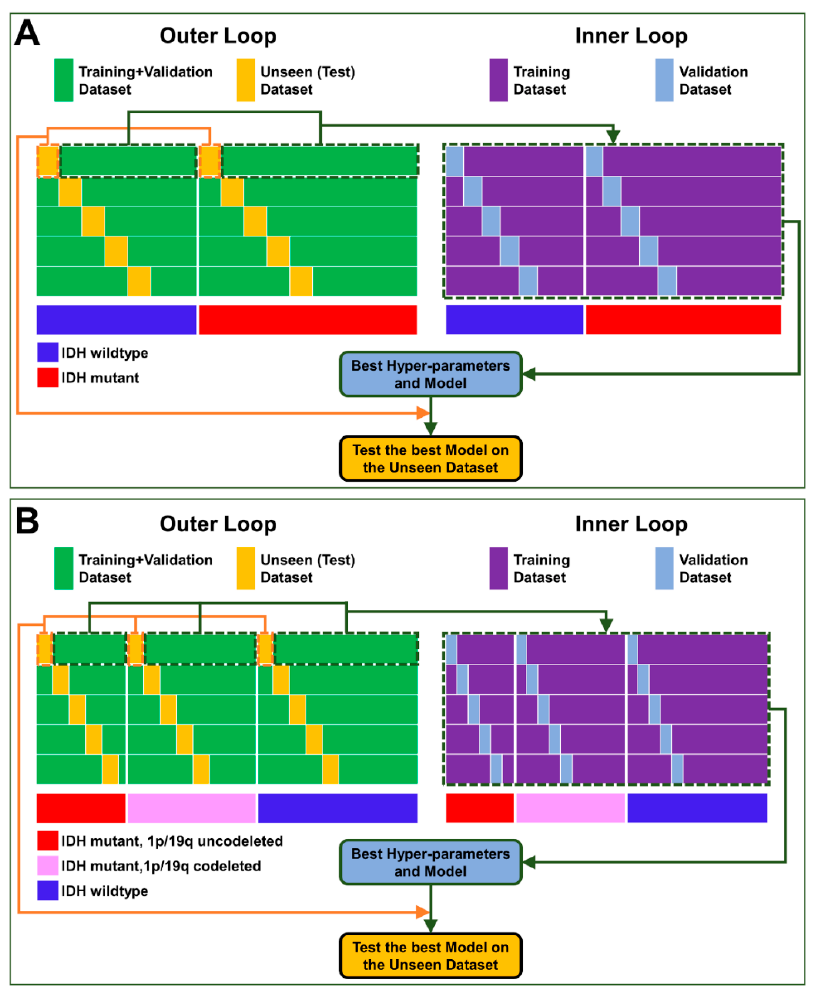
Figure 3. Scheme illustrating the nested cross-validation procedure for developing the network for ( A ) a two-group prediction task (as an illustrative example, IDH status prediction) and ( B ) a three- group prediction task (i.e., diagnosis of the three molecular subtypes according to WHO 2021 clas- sification). (Outer loop) Splitting the dataset into unseen test dataset (orange) and training ‒ valida- tion dataset (green) with a 5-fold cross-validation. (Inner loop) Splitting training ‒ validation dataset into training (violet) and validation (blue) datasets with a 5-fold cross-validation for feature extrac- tion and hyperparameter optimization. All splits were performed to have balanced classes in the validation and in the test sets. At the end of the outer loop, the results of the models tested on the 5 unseen test sets were averaged together to report the final classification results.